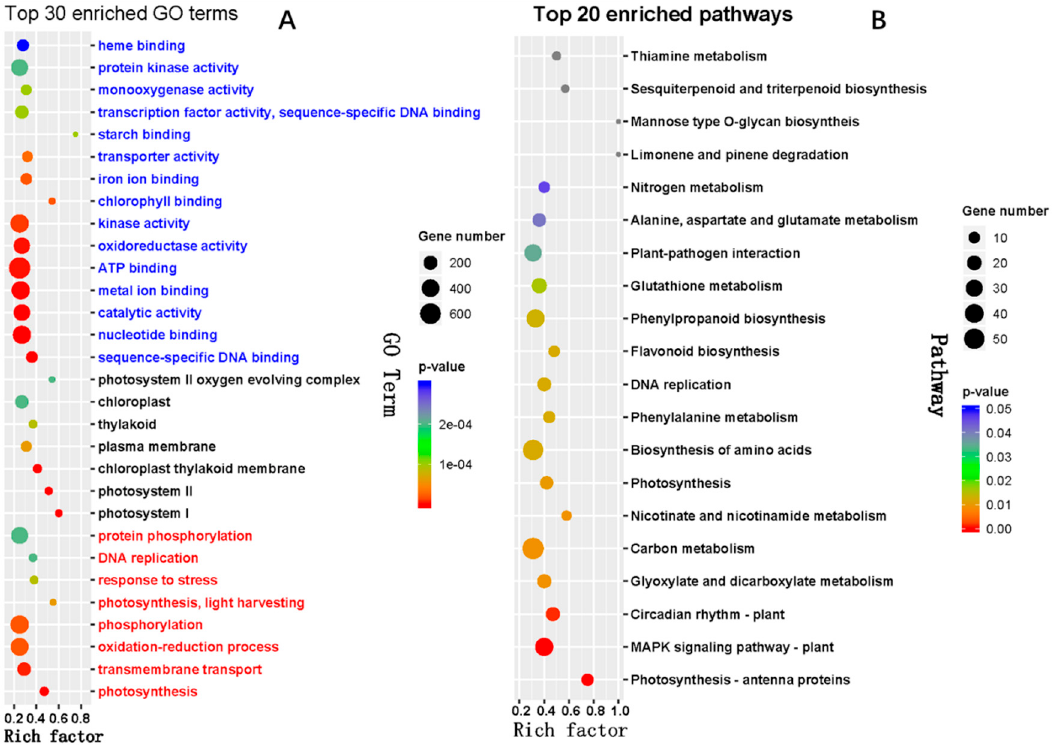
Figure 5. GO ( A ) and KEGG ( B ) functional classifications of differentially expressed genes (DEGs). Rich factor represents the ratio of the number of DEGs over the total number of genes in the specific GO term or KEGG pathway. The GO terms in red, black, and blue belong to biological processes, cellular components, and molecular functions, respectively.